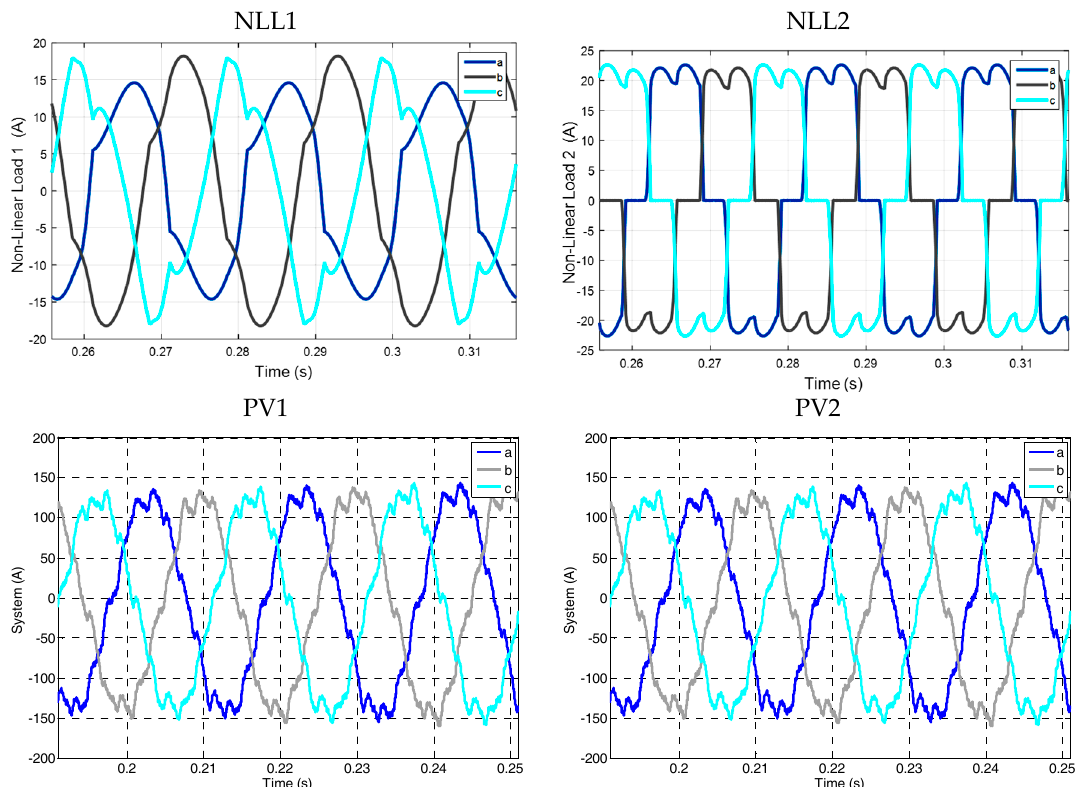
Figure 7. Output current waveforms of PVs and NLLs in different simulation.